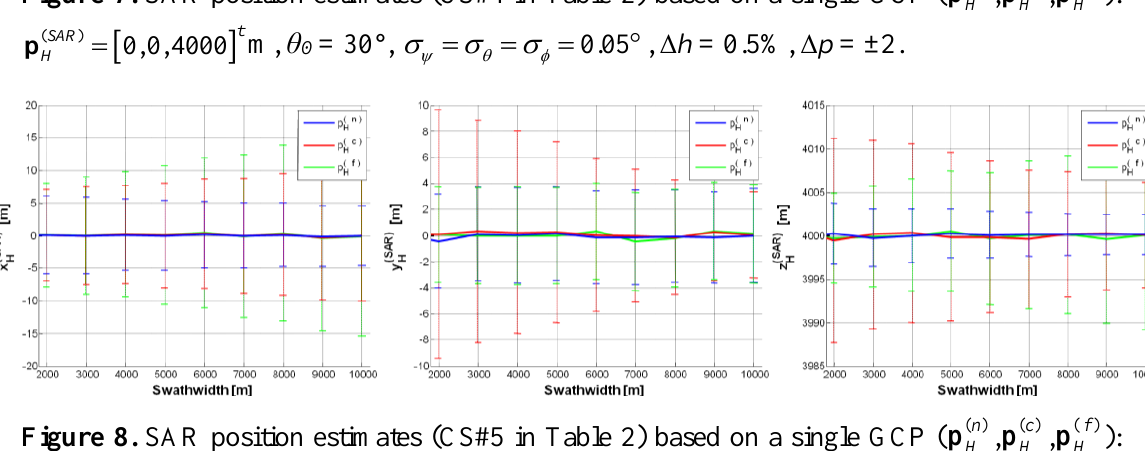
Figure 7. SAR position estimates (CS#4 in Table 2) based on a single GCP ( ( ) n